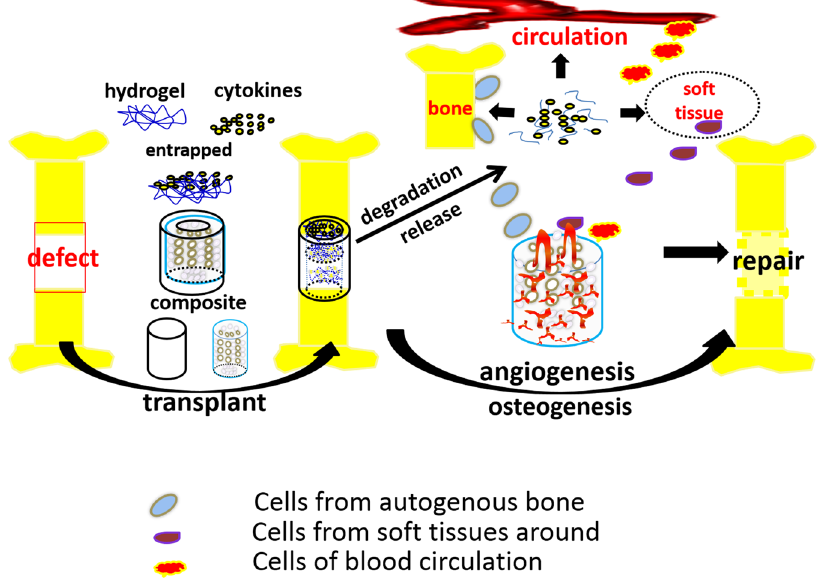
Figure 13. Cytokines-loaded hydrogel was combined with the CT-guided 3D-printing artificial bone scaffolds and implanted into the complete tibial defect (1.2 cm). With the mechanical support and biocompatibility of the porous scaffolds, the sustained release of cytokines and the stimulation on angiogenesis and osteogenesis, the defect was successfully